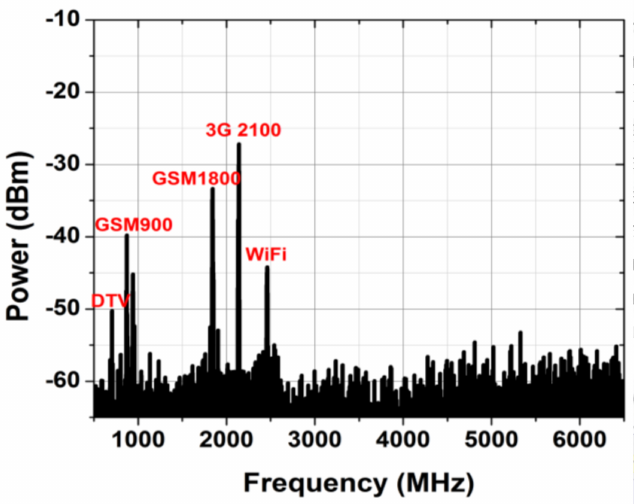
Figure 1. Power spectrum distribution measured in the campus of Xidian University,